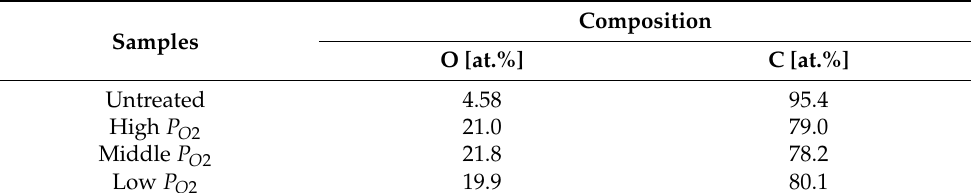
Table 1. Oxygen and carbon composition of untreated and vacuum-ultraviolet-treated films of woody carbon material calculated from C1s and O1s X-ray photoelectron spectra.